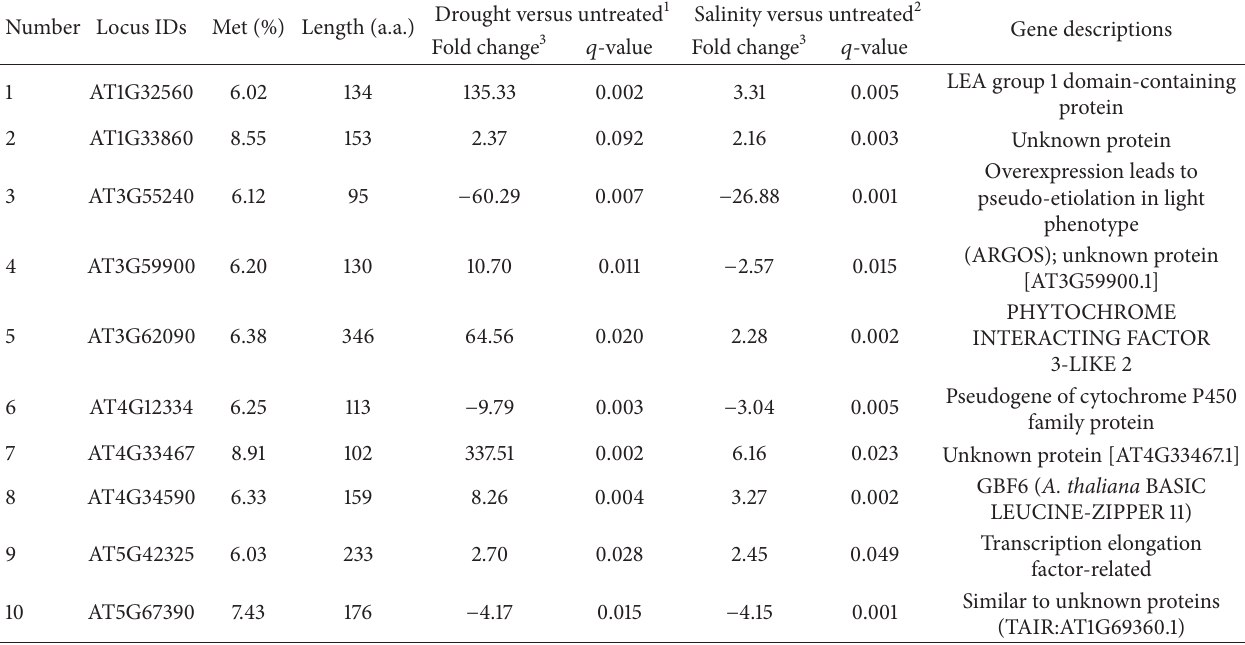
Table 1: Genes encoding AtMRPs whose expression levels were responsive to both drought and high salinity. Number Locus IDs